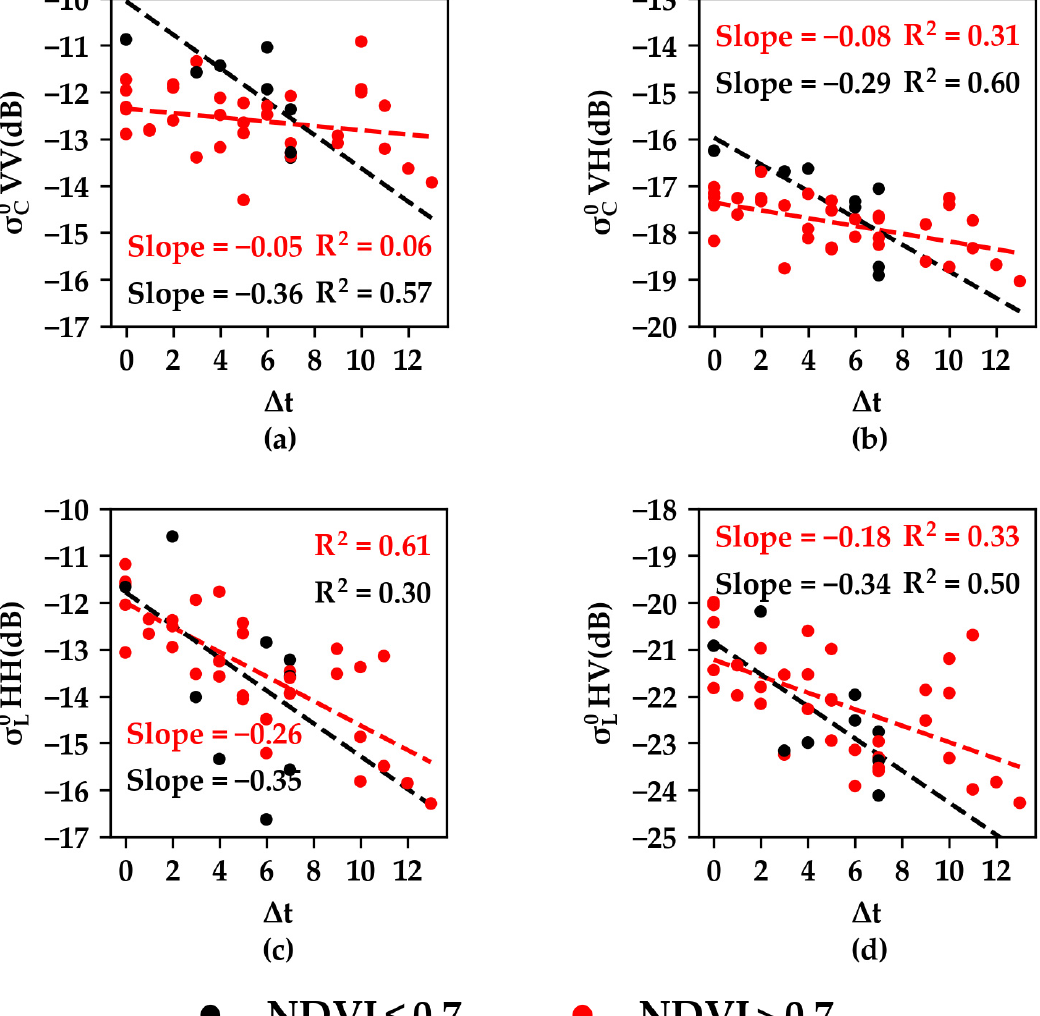
Figure 7. Variation in the σ 0 and σ 0 values as a function of the time difference between the SAR C L acquisition date and the last irrigation date for the C-band and L-band images acquired on 21/05/2019 in the growth cycle I. Each point represents a reference grassland plot. Black and red points correspond to grassland plots with NDVI ≤ 0.7 and NDVI > 0.7, respectively. ( a ) σ 0 in VV, ( b ) σ 0 in VH, ( c ) σ 0 C C